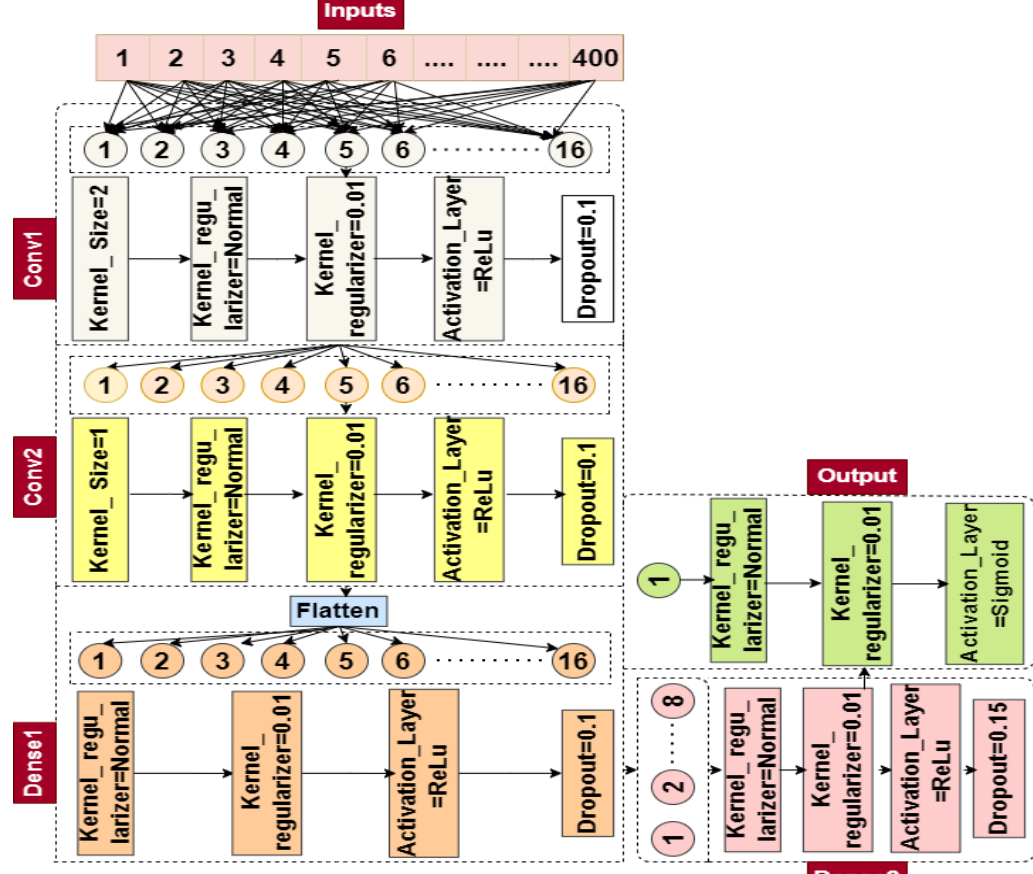
Figure 3. The architecture of optimized convolutional neural network (OCNN), a fine-tuned net- work.